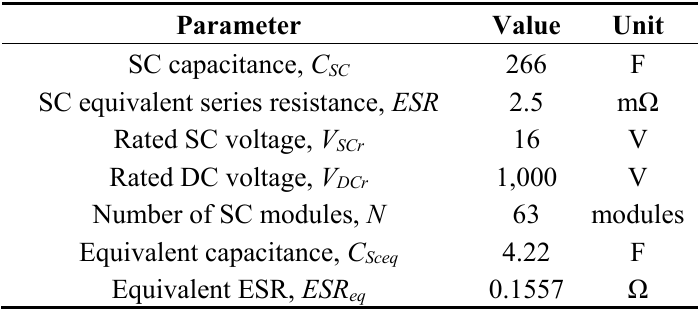
Table A8. DC-DC converter supercapacitor, German